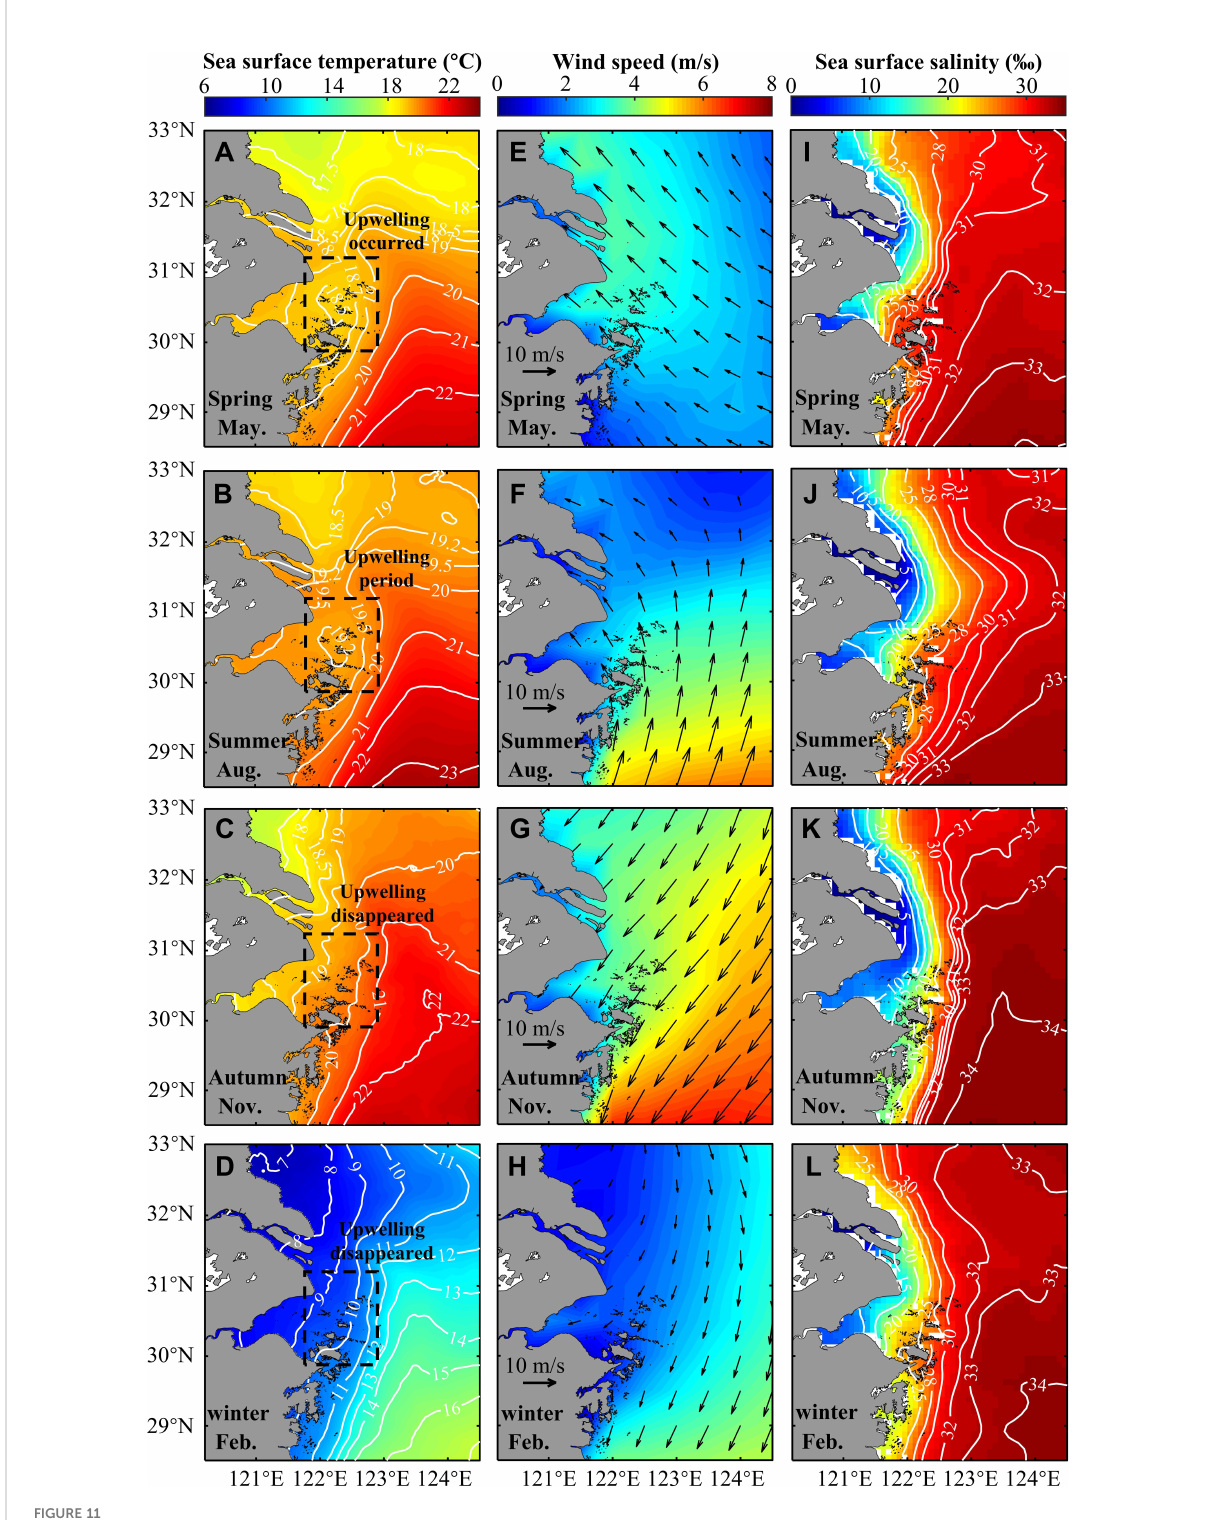
FIGURE 11 The seasonal variation of SST, wind and SSS for Zhoushan archipelago in 2020. (A-D) SST; (E-H) 10 m wind at the sea surface; (I-L) SSS. The black square is the study